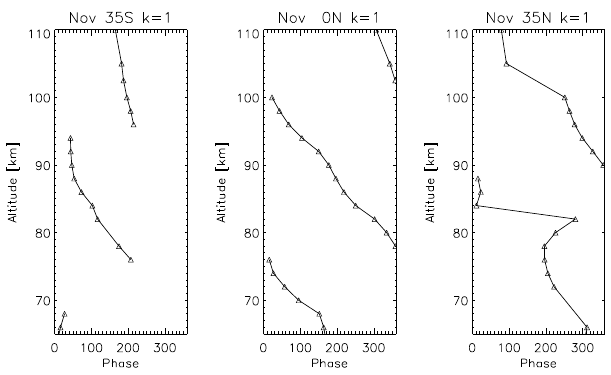
Figure 7. Phase of MIPAS average (2007–2012) | n odd − s | = 1 for November at 35 ◦ S (left), Equator (center) and 35 ◦ N